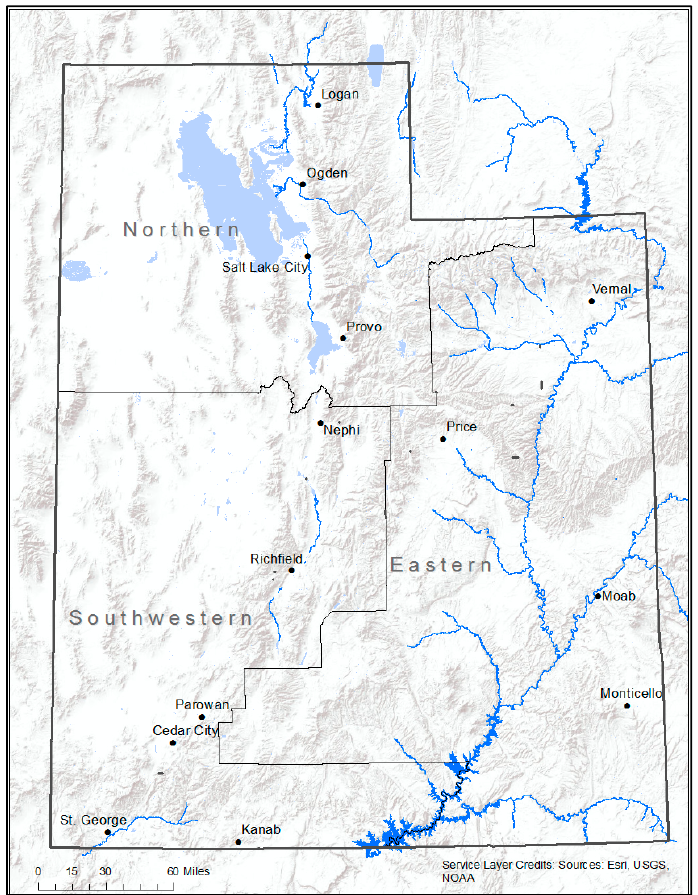
Figure 1. Map of the Utah geographic regions used for this paper.